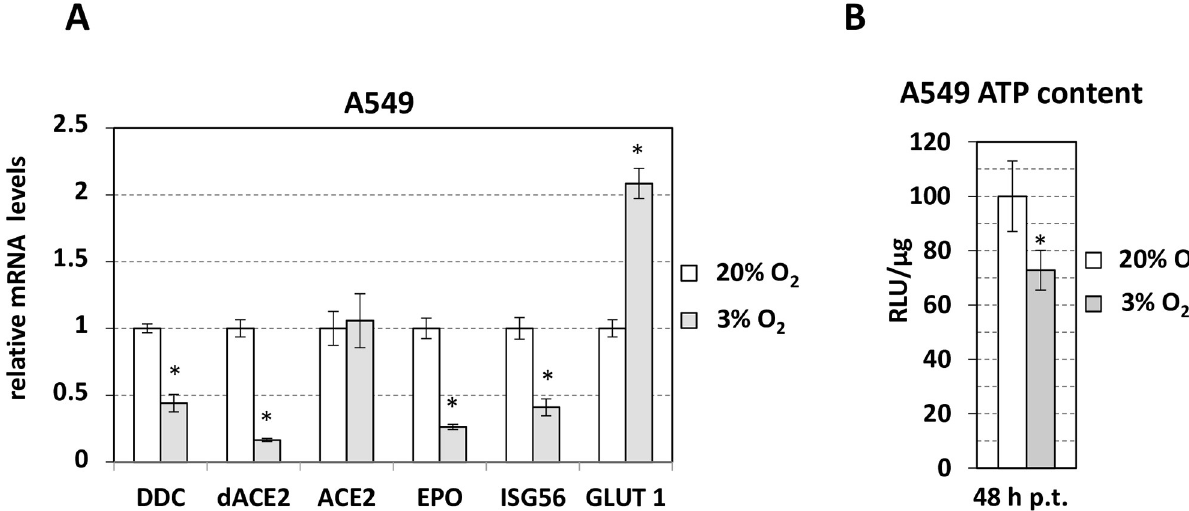
Fig 9. Effect of hypoxia on DDC , dACE2 , ACE2 , ISG56 , EPO and GLUT1 expression and on cell viability in A549 lung epithelial cells. Cells were cultured under atmospheric (20% v/v) or hypoxic (3% v/v) O 2 tension for 48 h. ( A ) Cell lysates were analyzed using RT-qPCR. YWHAZ mRNA levels were used for normalization. Bars represent mean values from three independent experiments in triplicates. Error bars indicate standard deviations. � p < 0.001 vs 20%-cultured cells (Student’s t test). ( B ) Bioluminescent measurement of intracellular ATP levels. Mean values (%) were normalized to ATP levels detected in cells cultured at 20% O 2 . � p < 0.01 vs 20%-cultured cells (Student’s t test). h p.t: hours post-treatment at 20 or 3% O 2 .